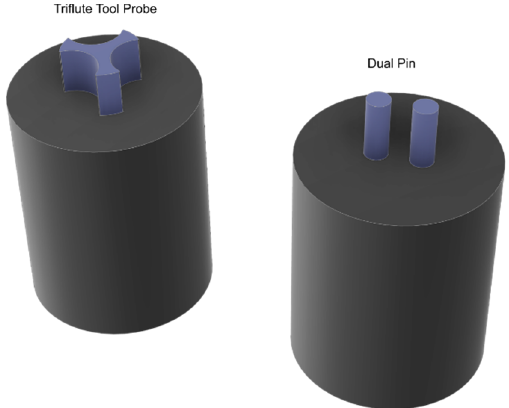
Figure 36. Schematic of triflute and dual pin used for FSSW of polymers.